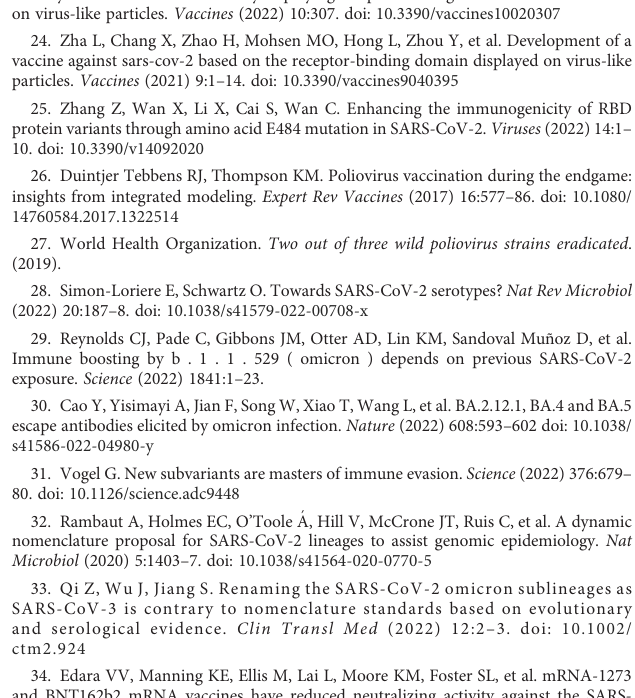
IgG antibody titers on d21 (A) and d28 (B) against RBDs. One-way ANOVA analysis was performed in Prism 9 (n=5), a =0.5 and statistical signi fi cance was displayed as p ≤ 0.05 (*), p ≤ 0.001 (**), p ≤ 0.005 (***), p ≤ 0.001 (****).